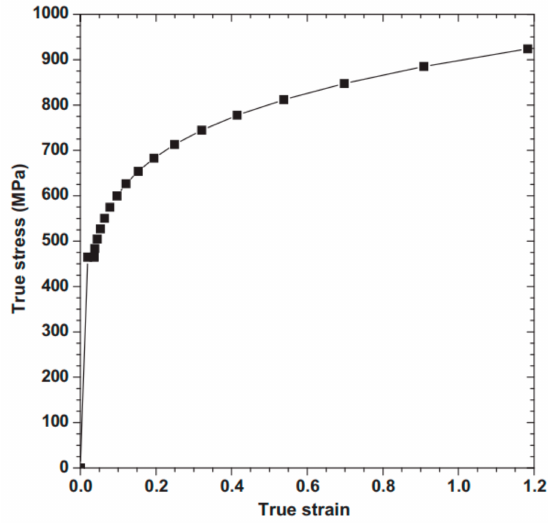
Figure 4. True stress–strain curves of API 5L X65 steel pipe [29]. Table 2. Mechanical property of API 5L X65 steel